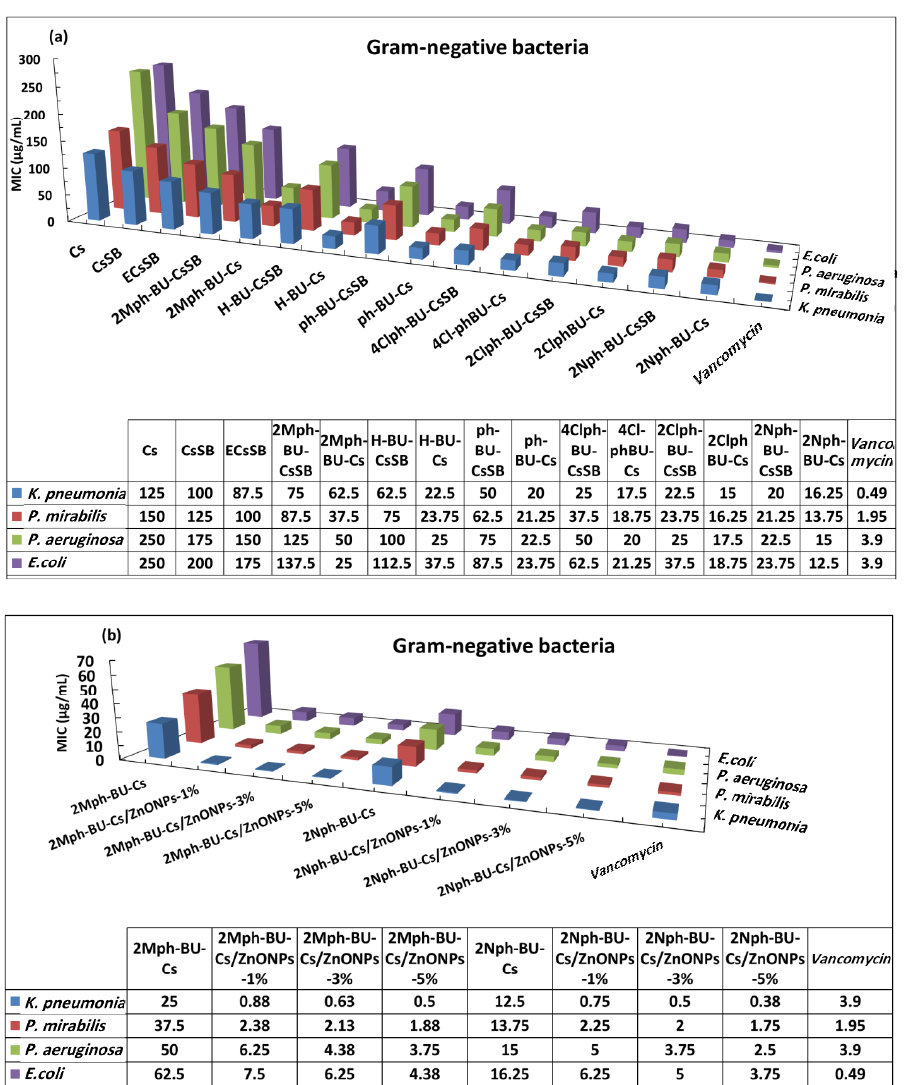
Figure 9. MIC index for: ( a ) R-BU-CsSB and R-BU-Cs hydrogels, and ( b ) 2Nph-BU-Cs/ZnONPs and 2Mph-BU-Cs/ZnONPs composites against the inspected Gram-negative bacteria.